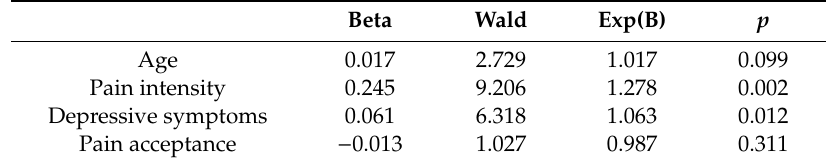
Table 3. Results of logistic regression analysis of variables associated with opioid